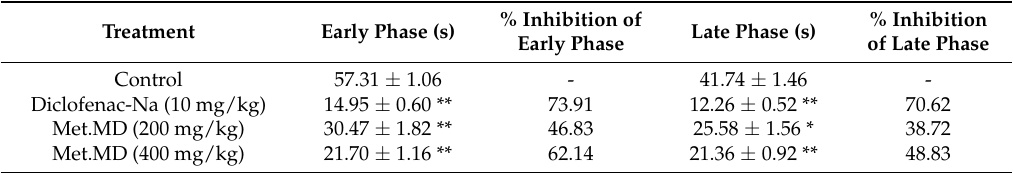
Table 2. Antinociceptive effect of methanol extract of M. denticulata leaves in formalin-induced licking test in